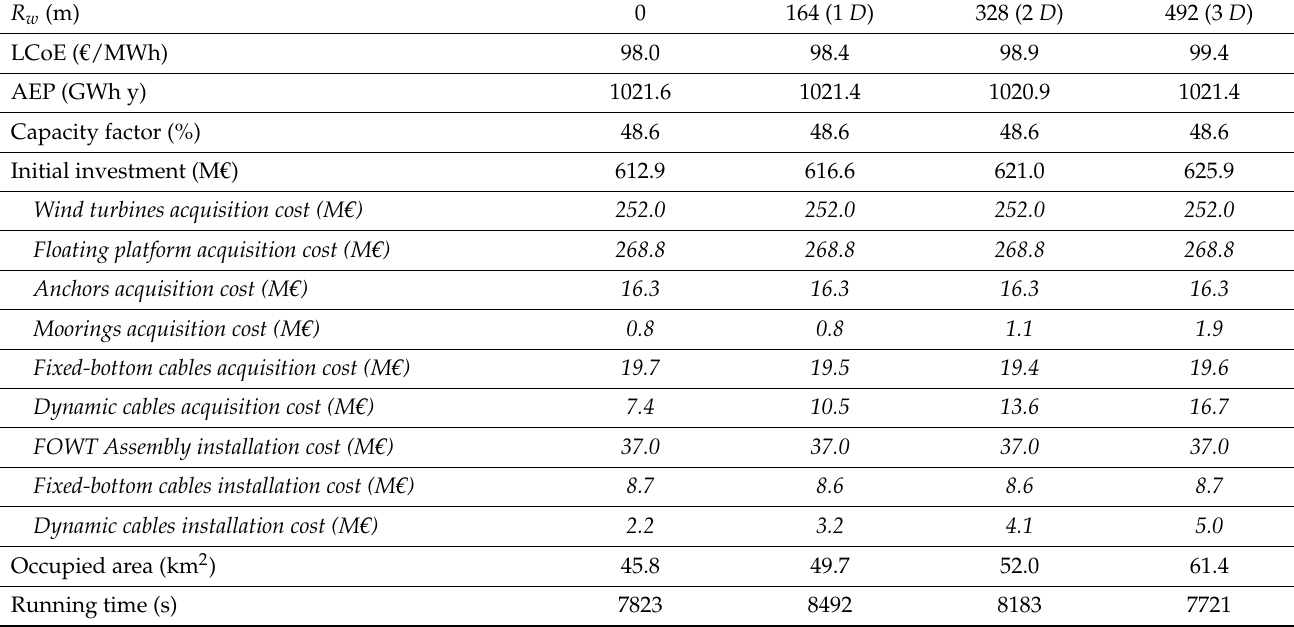
Table 3. Main techno-economic data obtained for Case